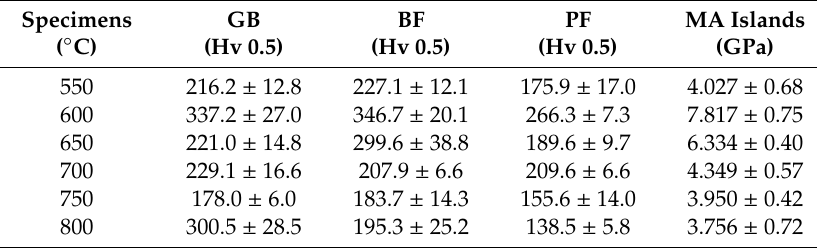
Table 2. The hardness of the microstructural